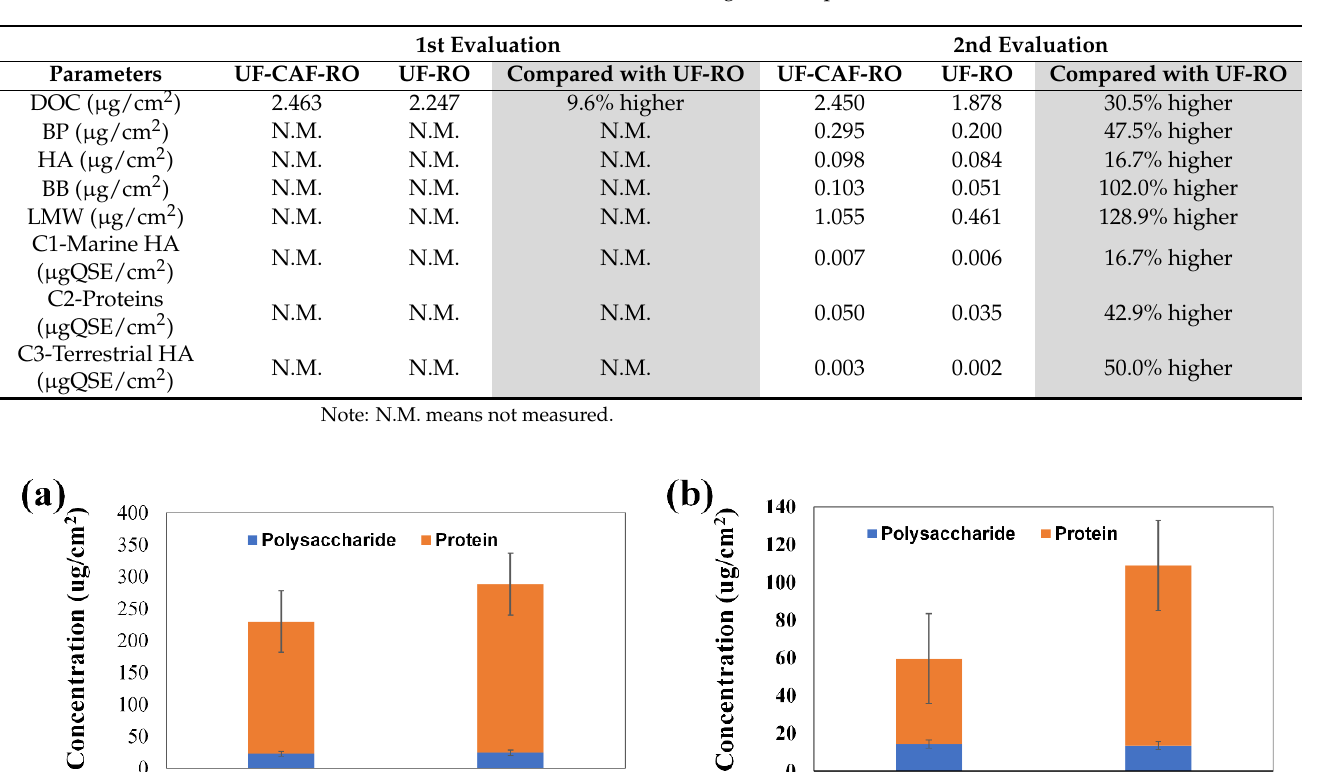
Figure 5. EPS content of the RO membranes with and without CAF pre-treatment in the ( a ) 1st eval- uation and ( b ) 2nd evaluation.